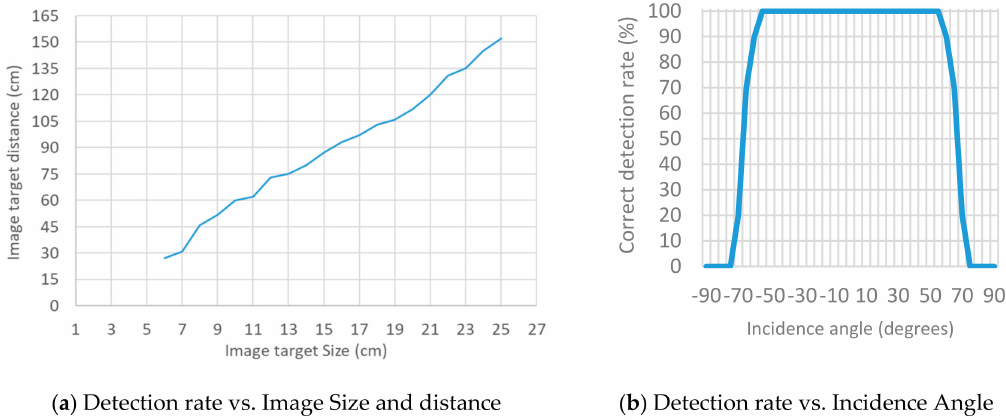
Figure 10. Successful image target detection depending on size and angle